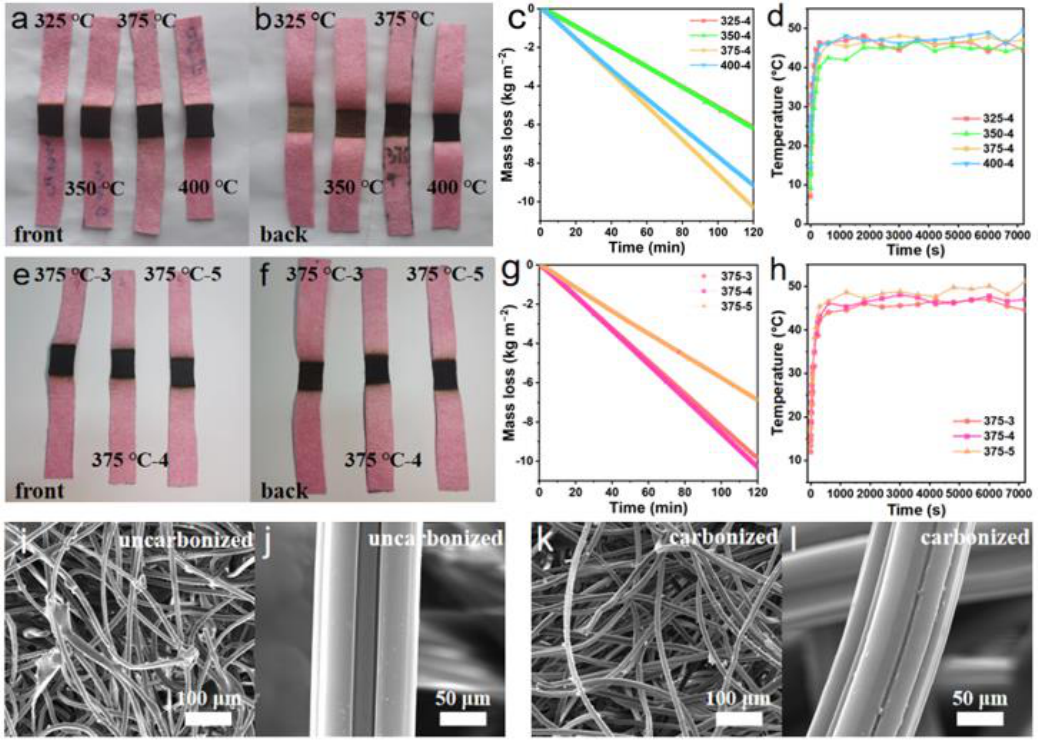
Figure 5. Effect of carbonization time and temperature on solar evaporation performance: coconut fiber membrane carbonized at different temperatures: ( a ) front view and ( b ) back view. ( c ) Solar evaporation performance and ( d ) surface temperature of coconut fiber membrane treated at different carbonization temperatures. Coconut fiber membrane carbonized at different times: ( e ) front view and ( f ) back view. ( g ) Solar evaporation performance and ( h ) surface temperature of coconut fiber membrane treated with different carbonization times. SEM images of ( i , j ) uncarbonized and ( k , l ) carbonized coconut fiber membranes.